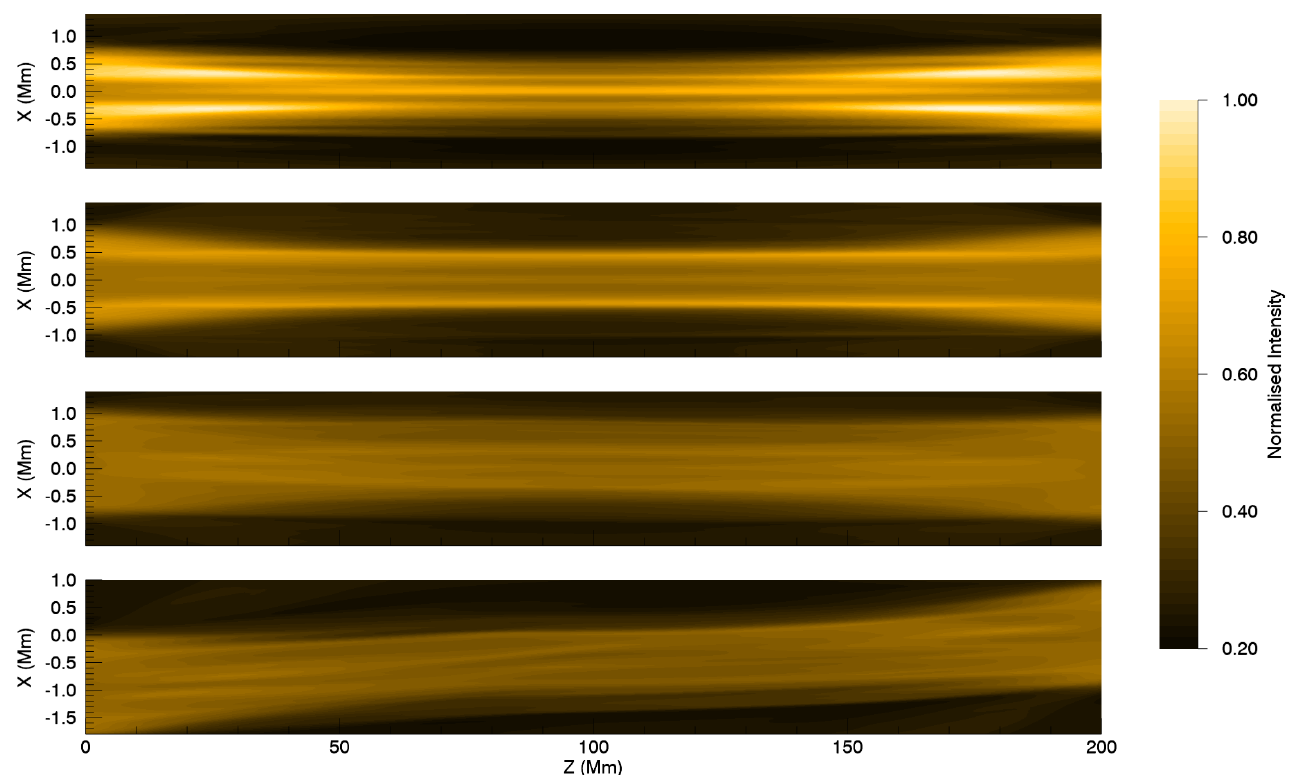
Figure 12. Synthetic intensities as would be observed with the Atmospheric Imaging Assembly (AIA) 171Å channel. Synthetic emission from the ResUni, BbUni, ResMulti, and BbMulti ( top to bottom ) simulations at t = 3100 s. The line-of-sight (LOS) is parallel to the y axis and the emission shown is normalised by the maximum value in the ResUni case. See text for